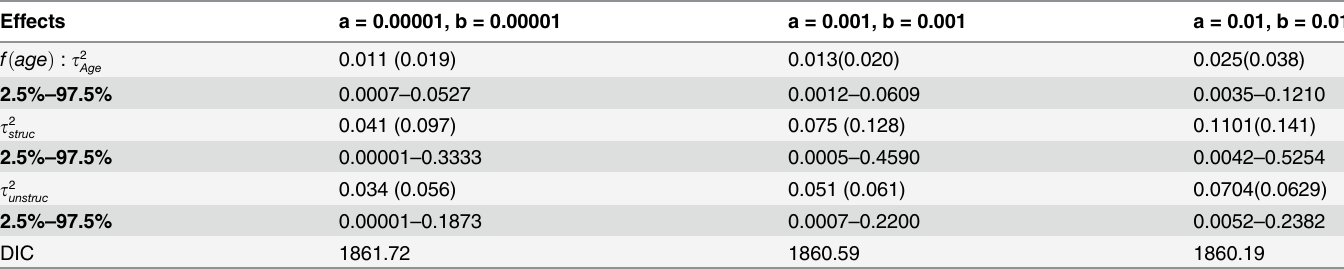
Table 5. Sensitivity analysis: DIC, posterior mean variance, its standard error (within brackets), and 95% CI based on Model 5.